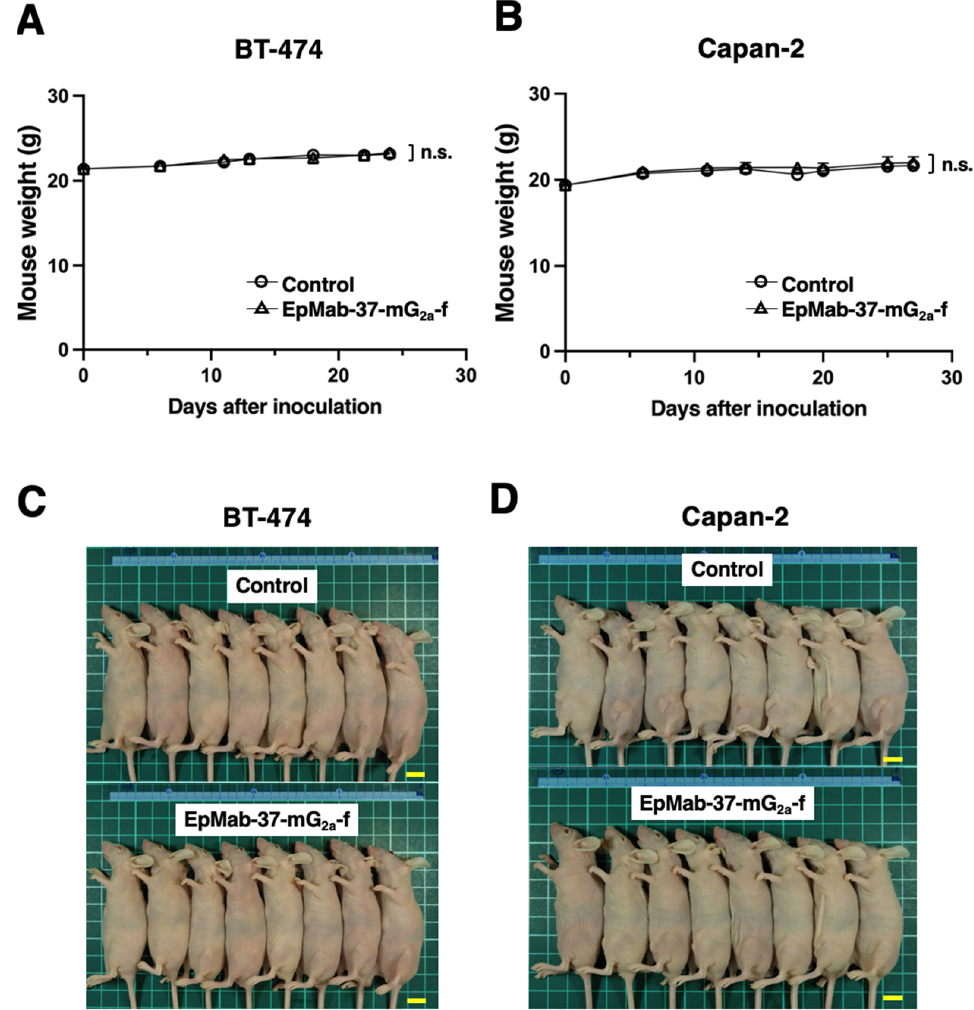
Figure 5. Mice body weights and appearance. ( A , B ) Body weights in ( A ) BT-474 and ( B ) Capan-2 xenografts-implanted mice on the indicated days (ANOVA and Sidak’s multiple comparisons test). ( C , D ) Body appearance in ( C ) BT-474 and ( D ) Capan-2 xenografts-implanted mice on day 24 and 27, respectively (scale bar, 1 cm). n.s., not significant.